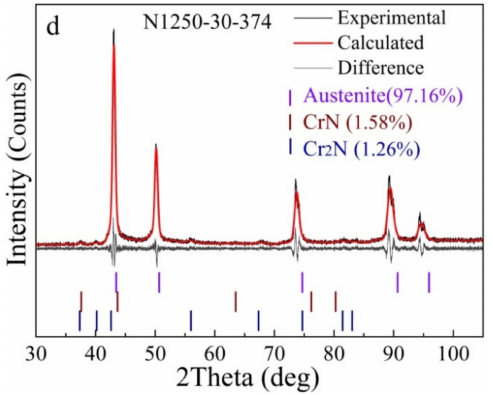
Figure 4. Refined XRD patterns of alloys: ( a ) the as-received powders; ( b ) XRD patterns of the as-fabricated alloys; refined XRD patterns of alloys: ( c ) N1200-30-374; ( d )